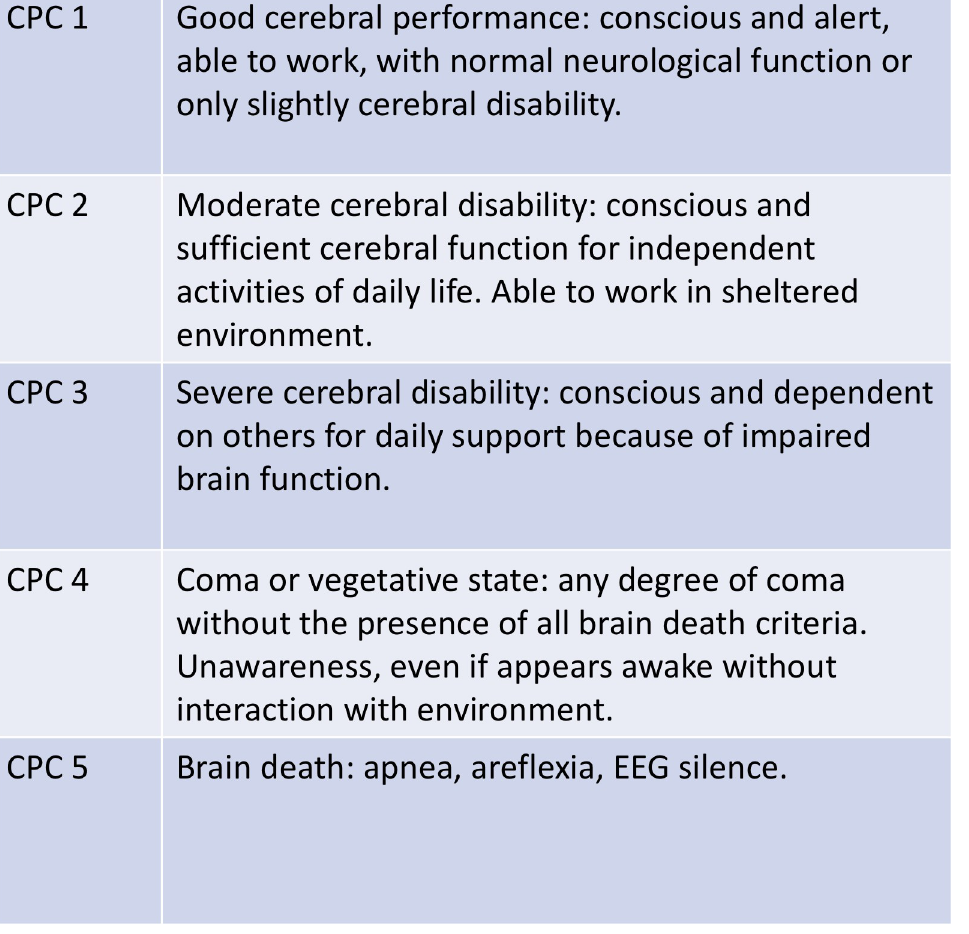
Fig 2. Cerebral performance categories (CPC)